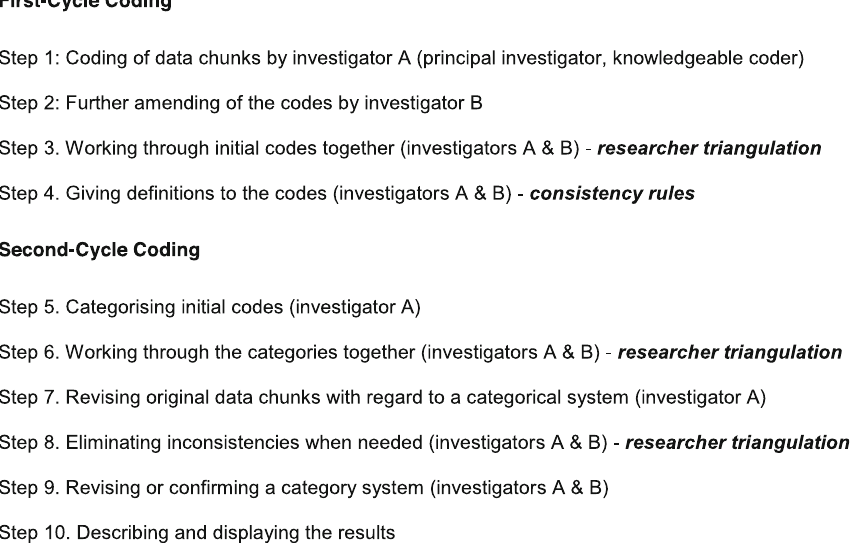
Fig. 2 Data Analysis Procedure with the Corresponding Strategies for Ensuring the Quality of Data